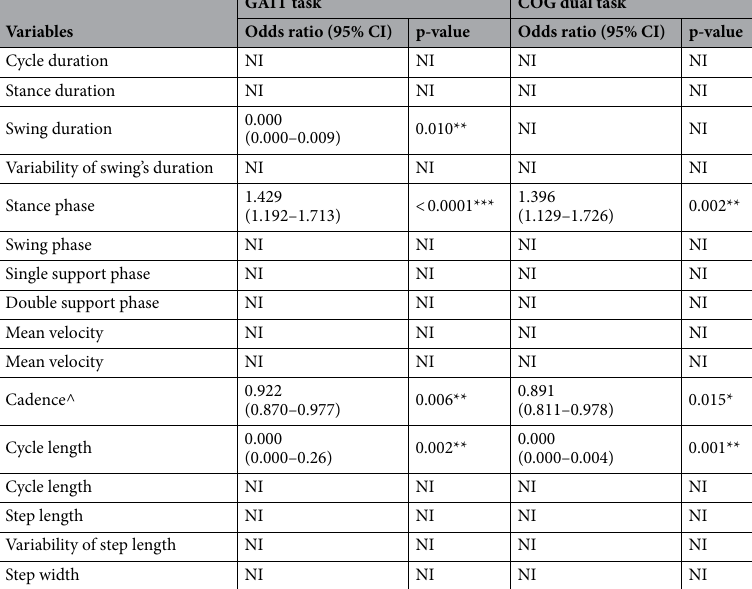
Table 3. Multinomial logistic regression results for GAIT and COG tasks to distinguish PD and PSP. Odds ratio (95% confidence interval) and p-value for each variable were considered in the model. PD Parkinson’s disease, PSP progressive supranuclear palsy, NI not included. *Significance level at 0.05. **significance level at 0.01. ***significance level at